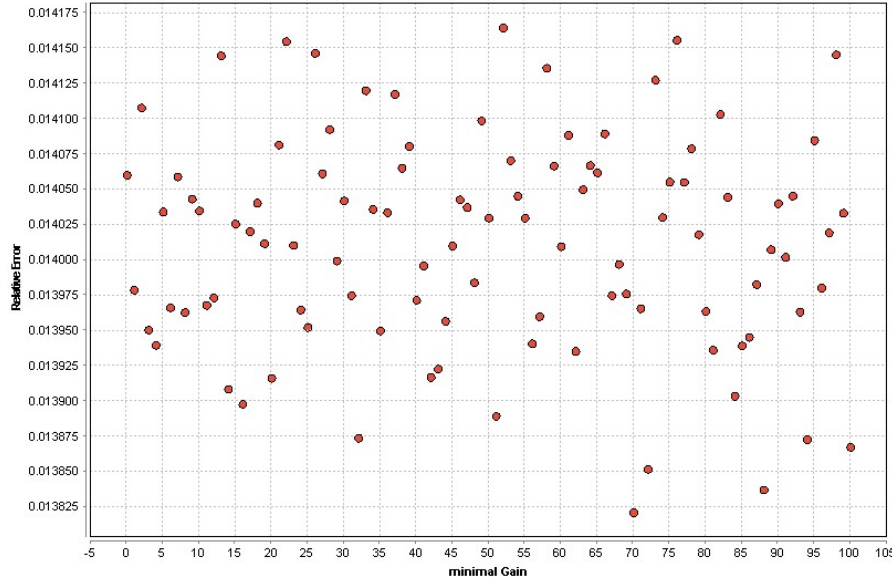
Figure 10. Minimal gain tuning results for Random Forest model.